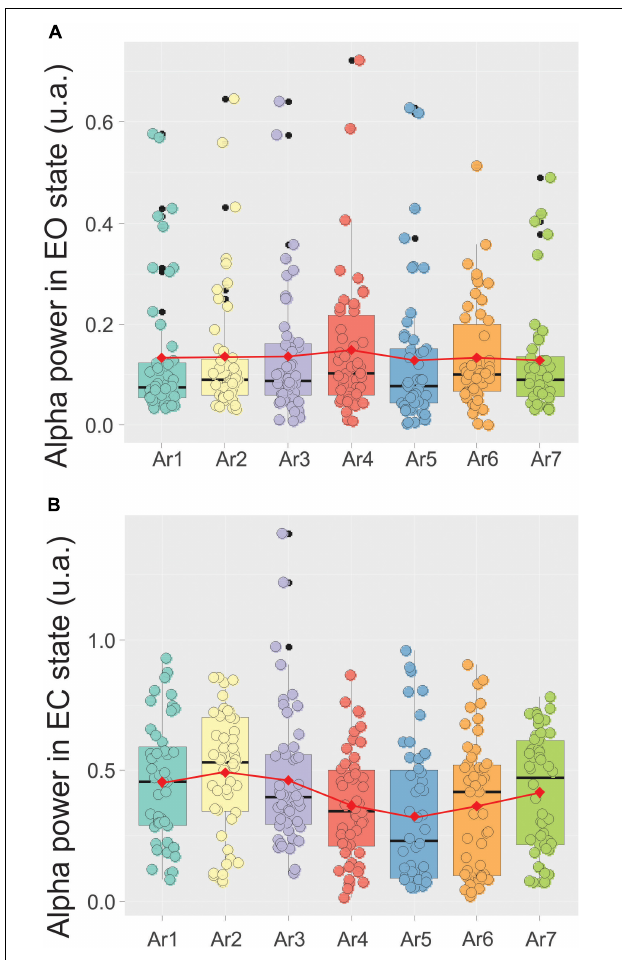
FIGURE 6 | Evolution of the mean ± SD of the alpha power in a box plot configuration in the EC state (A) and the eye opened (EO) state (B) from AR1 (control before the RB session) to AR7, in the 10 subjects of the first control group.